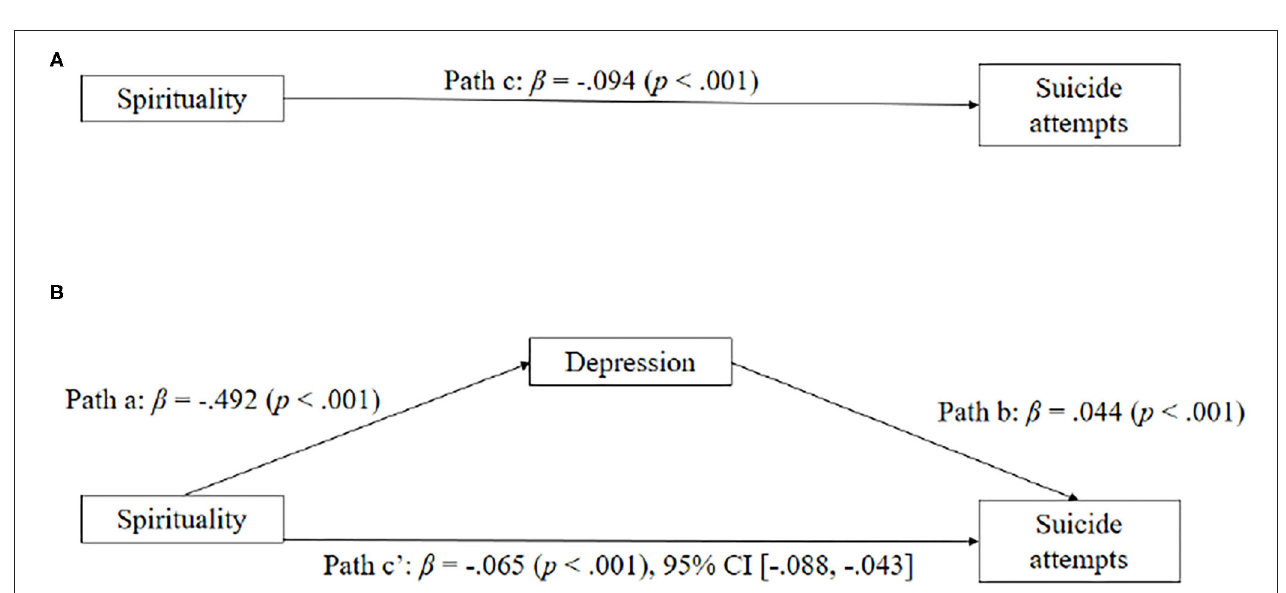
FIGURE 3 | (A,B) Depressive symptoms as mediators between spirituality and suicide attempts. Standardized coefficients are shown for each path (with p in parentheses).